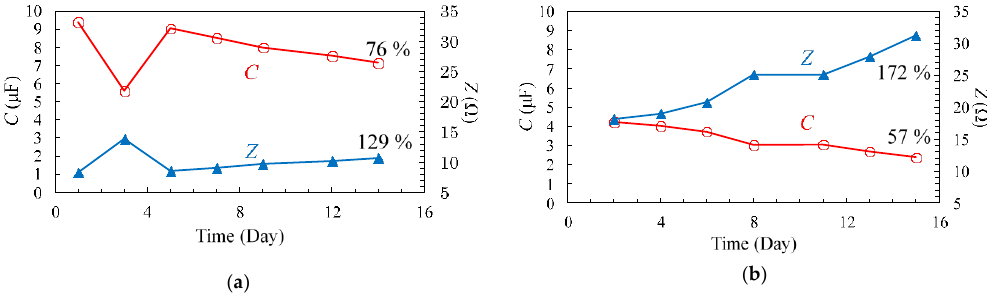
Figure 8. C ( a ) and Z ( b ) measured at 80 °C in variable temperature (80–5 °C) degradation tests at 1 kHz.